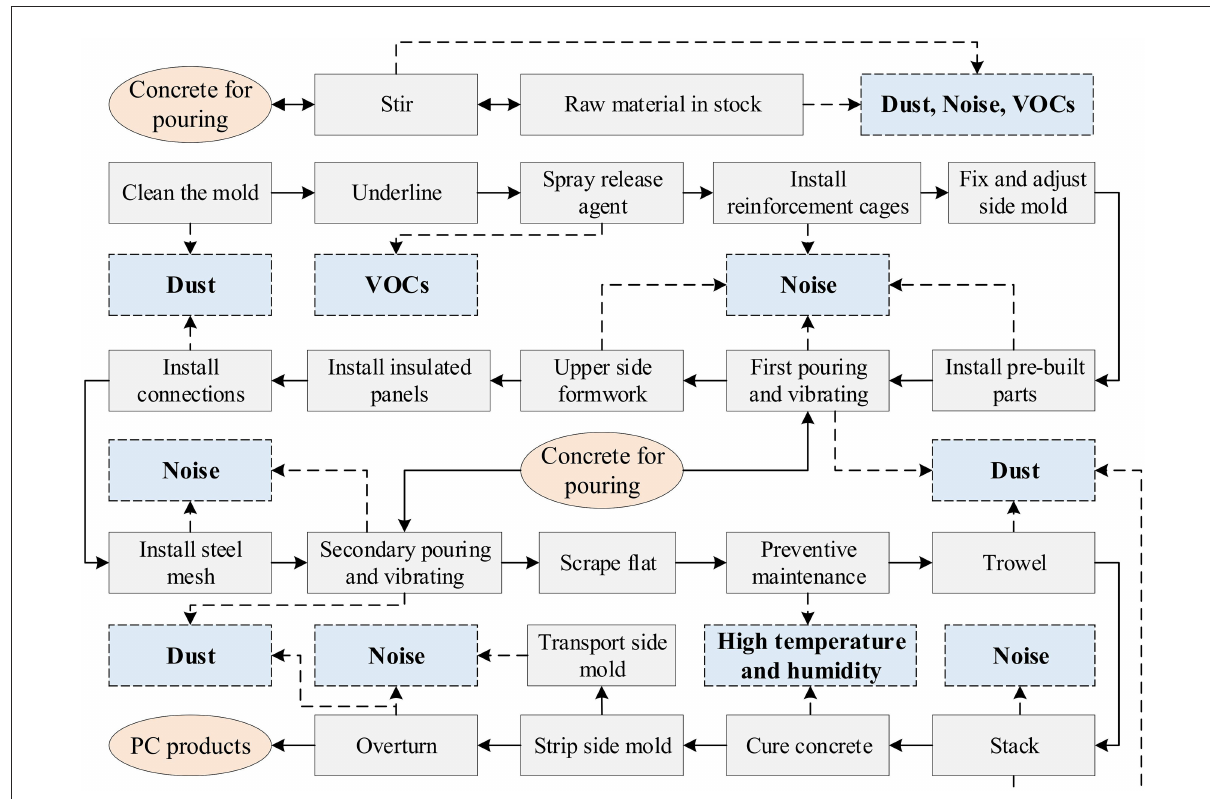
FIGURE3 Types of potentially harmful environmental release from the production of precast concrete facade panels.